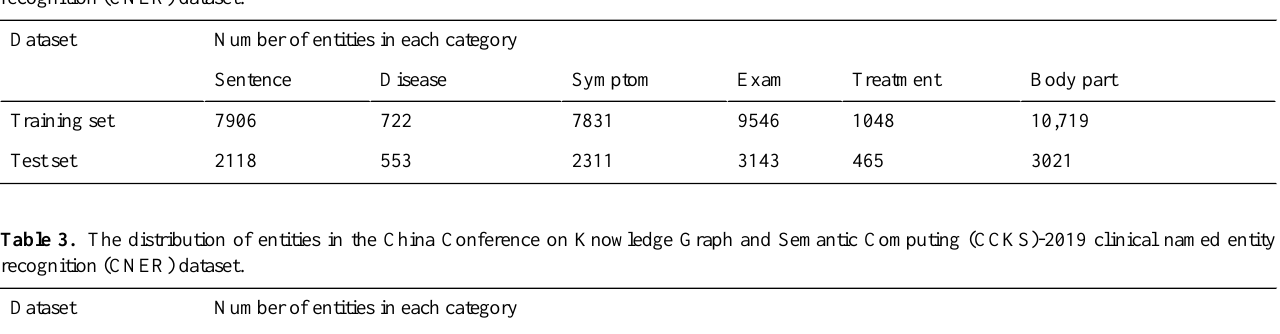
Table 2. The distribution of entities in the China Conference on Knowledge Graph and Semantic Computing (CCKS)-2017 clinical named entity recognition (CNER) dataset.